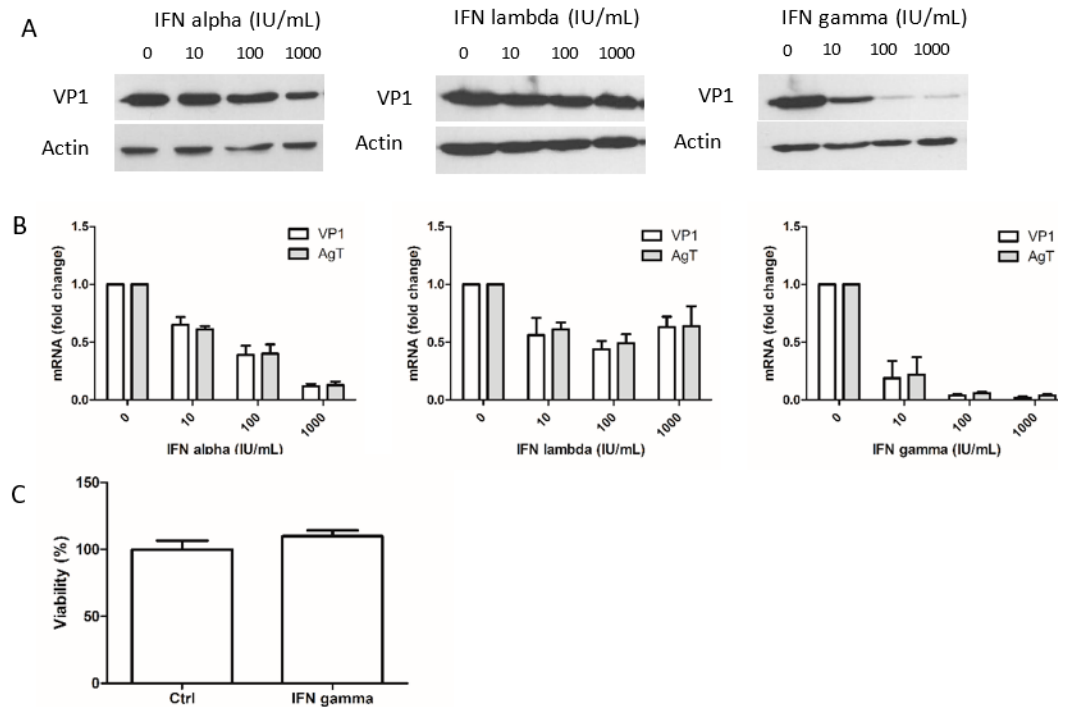
Figure 1. Effects of the three types of interferons (IFN) on BKPyV multiplication. ( A ) Vero cells were pre-incubated for 6 h with different concentrations of IFN-alpha, lambda or gamma and then inoculated for 3 h with BKPyV (multiplicity of infection, MOI = 0.5). Total cellular proteins were extracted 72 h